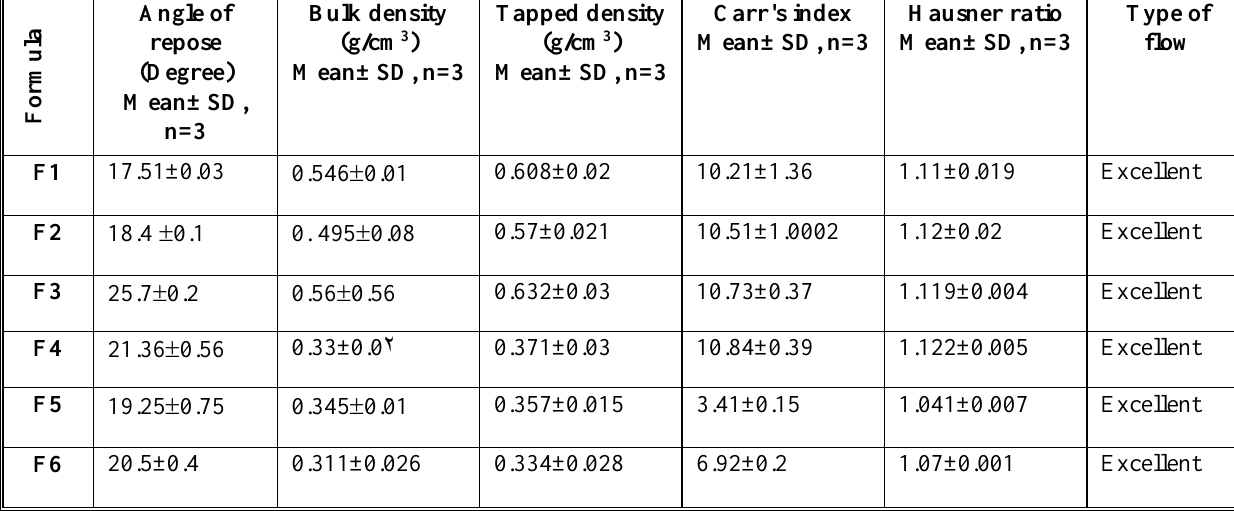
Table 4. Pre-Compression Physical Parameter’s for Core Powder Blend of Sumatriptan